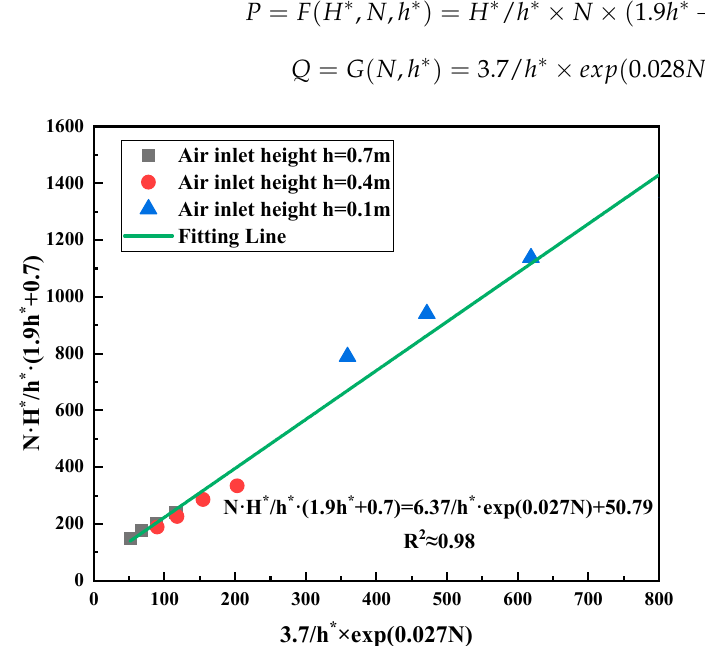
Figure 11. The relationship between the dimensionless smoke layer height and the dimensionless air supply volume.